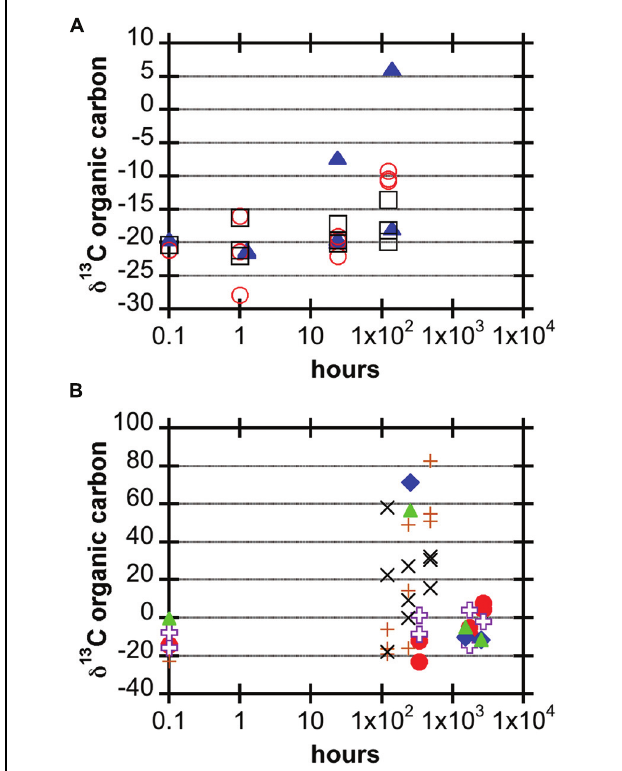
FIGURE 2 | Carbon stable isotopic composition of organic matter in basalt samples after incubation, expressed in the delta notation of per mil (note logarithmic time scale). (A) JdF2009 (blue filled triangles), Ula Nui (black open squares), and Marker 2 (red open circles). (B) U1382A 3R4 (purple open crosses), U1382A 7R2 (red filled circles), U1383C 13R1 (blue filled diamonds), U1383C glass (green filled triangles), J2-626-R1 (brown plus signs), J2-627-R3 (black